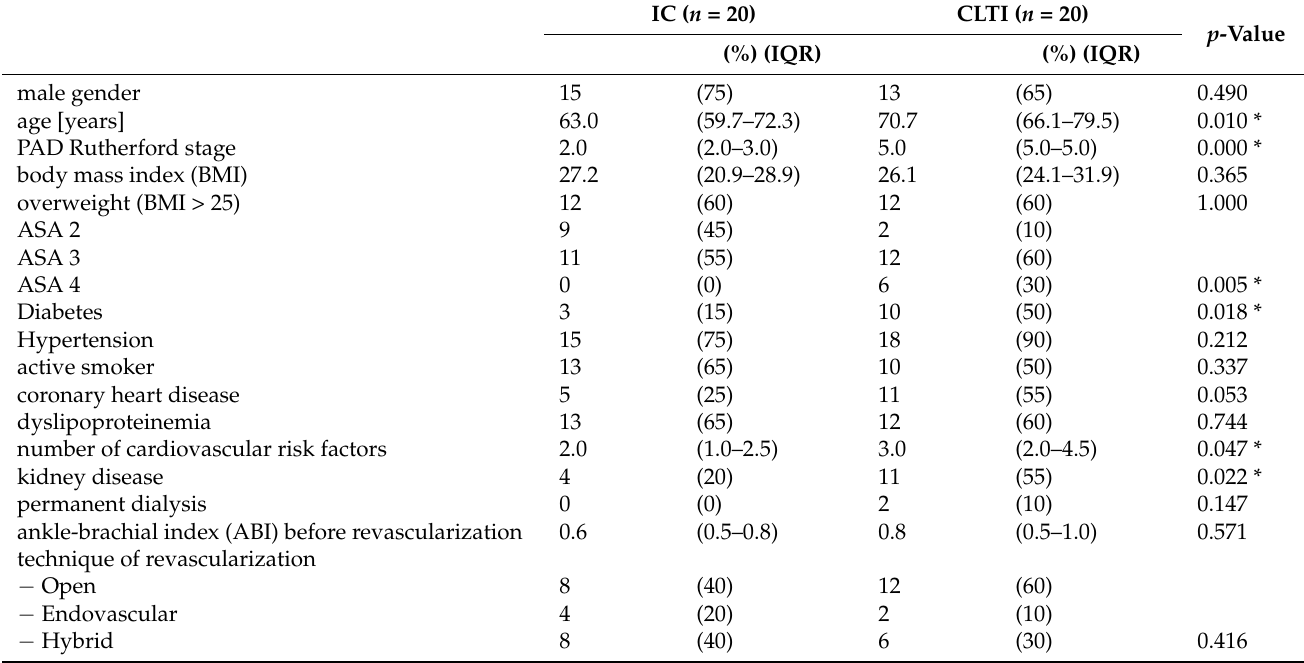
Table 1. Overview of anthropometric data of the study cohort of patients with peripheral arterial disease (PAD) in the stage of intermittent claudication (IC) or chronic limb-threatening ischemia (CLTI). Categorical variables are expressed as numbers and percentages in brackets. Continuous variables are expressed as the median with the interquartile range (IQR) in brackets. p -values were generated with non-parametric Mann–Whitney U tests. An asterisk * marks a p -value < 0.05. ASA: American Society of Anesthesiologists’ comorbidity